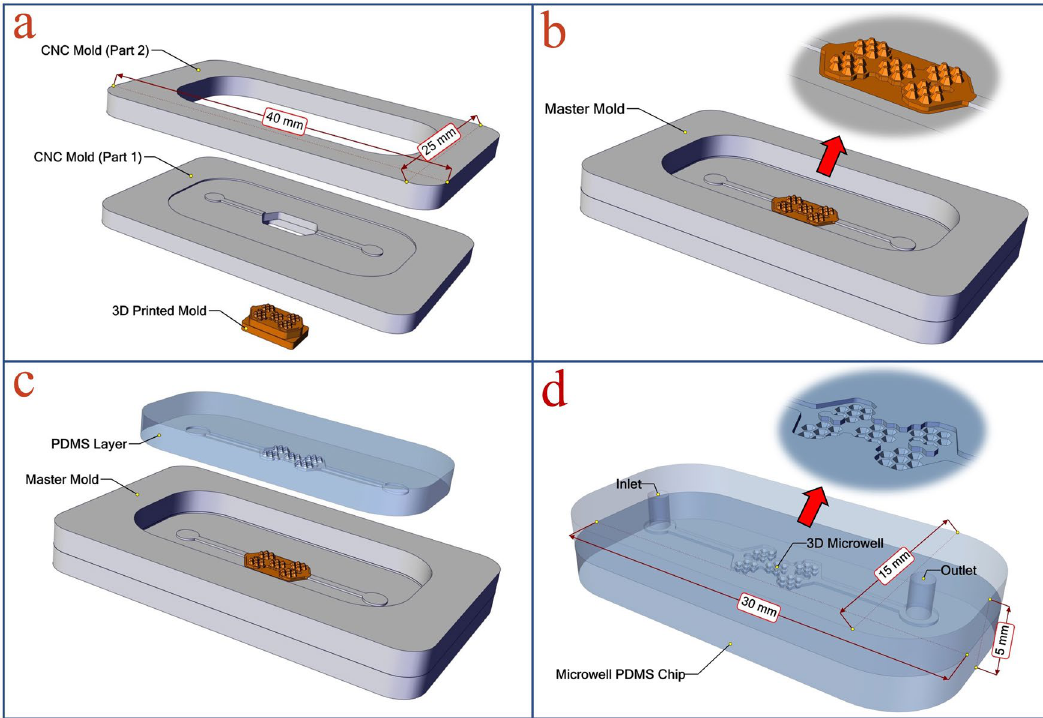
Figure 1. The manufacturing steps of the master mold: ( a ) the exploded view of the master mold that consists of one 3D printed mold and two CNC micro-milling parts. ( b ) The assembled master mold. ( c ) The PDMS casting process. ( d ) The final PDMS microfluidic chip. [This figure was created by SOLIDWORKS 2016 (www. solid works